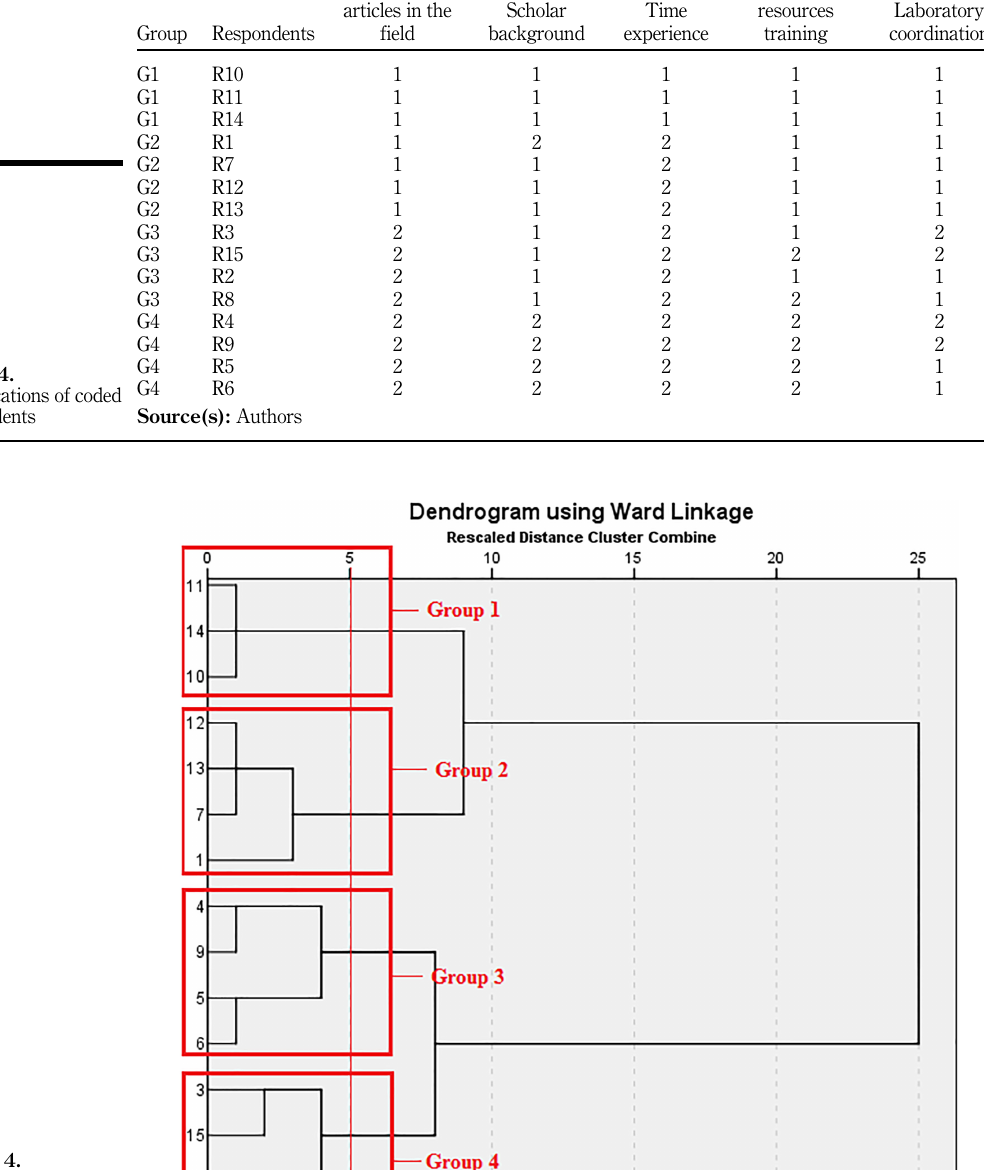
Figure 4. Dendrogram showing groupings of respondents according to